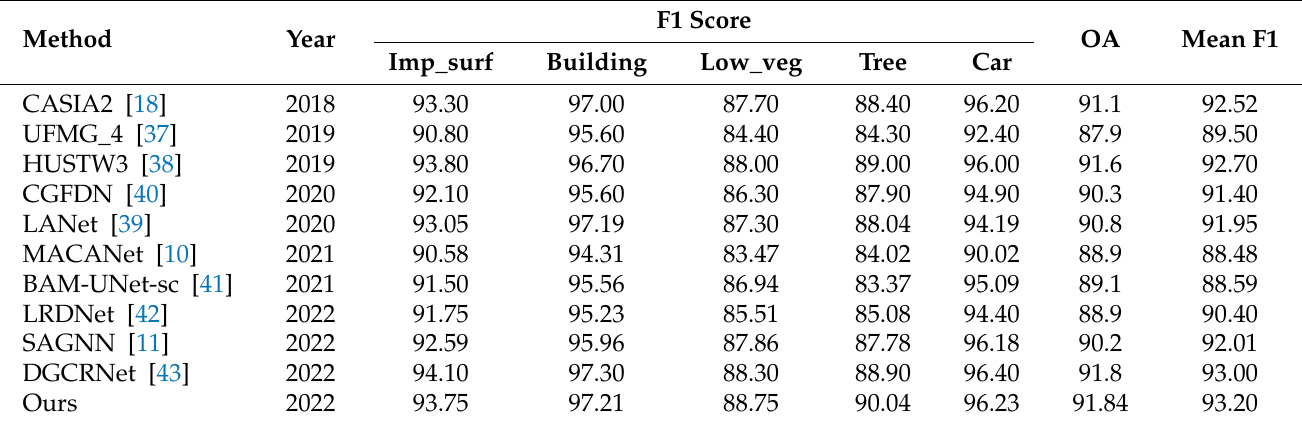
Table 6. Comparisons between the LGNet and other state-of-the-art methods on the Potsdam